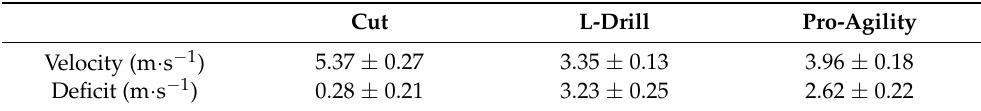
Table 4. Descriptive data (mean ± standard deviation) of the change of direction velocity and deficit for the three distinct protocols performed.